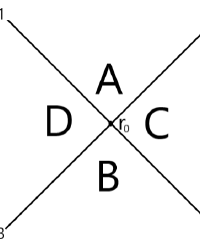
Figure1. Twonullshellscrossinatwosurfaceofradius r 0 dividingthespacetimeintofourregions. Figure 1. Two null shells cross in a two surface of radius r 0 dividing the spacetime into four regions. Weareparticularlyinterestedinthesituationinwhich r 0 isveryclosetotheinnerhorizon. We are particularly interested in the situation in which r 0 is very close to the inner Duetothenullnatureoftheshells,theorthogonalvectorisalsotangentialtotheshell, and the extrinsic curvature is given by the tangential derivative of the metric along the shells. Therefore,theextrinsiccurvaturehastobecontinuousacrosstheshell,anditcannot dependonwhichregionofspacetimeisusedinthecomputation[11,12]. Thiswouldnot betrueiftheshellsweretimelike,astheextrinsiccurvaturewouldnotbewelldefined,as itwoulddependonthefourdimensionalmetricwhichisdifferentinthetwosideofthe shell. Now,wecanrewriteEquation(5)